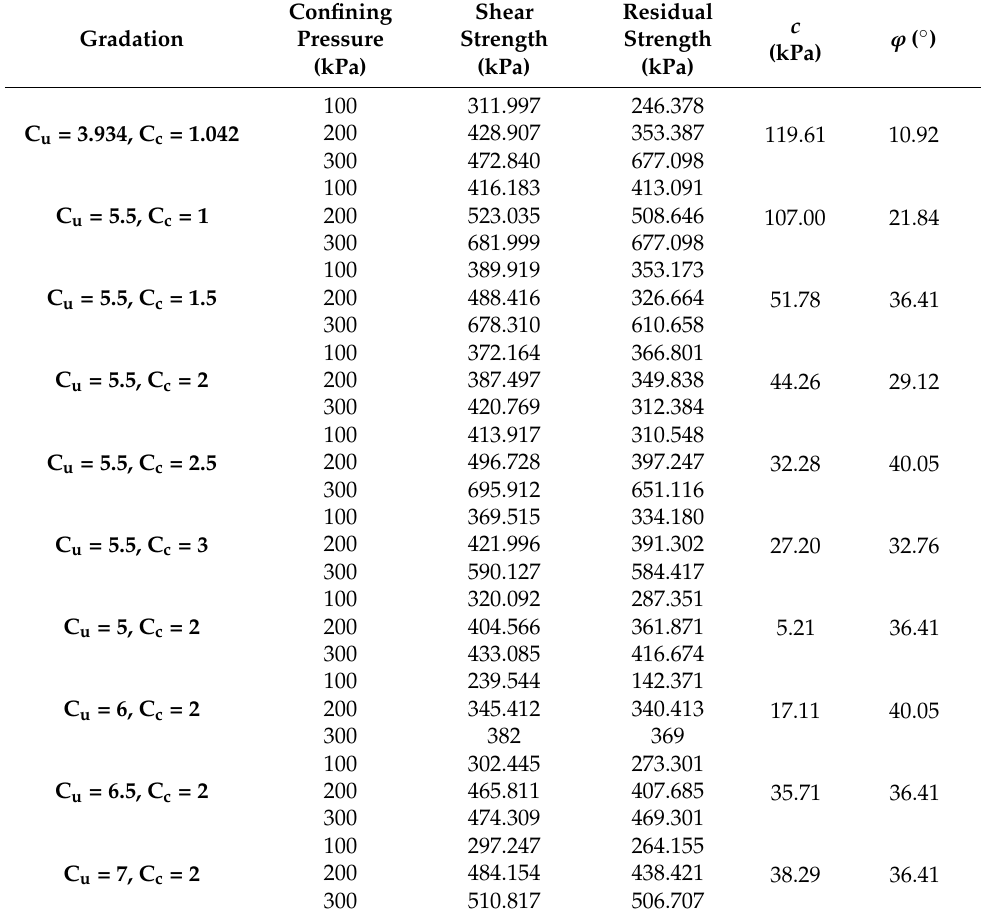
Table 5. Strength record table under different test